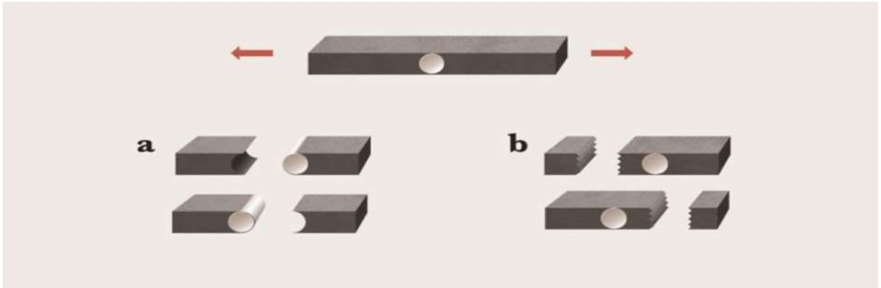
Figure 2. The broken specimens after MTBS testing; ( a ) adhesive failure; ( b ) cohesive failure; (a + b) mixed